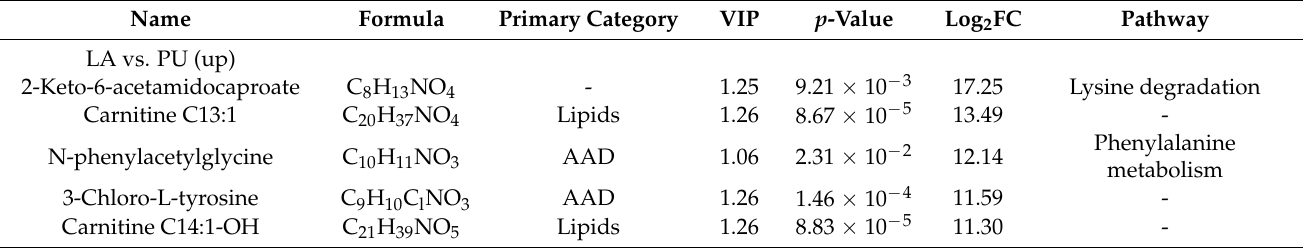
Table 2. The top five DAMs (up- or down) identified based on log 2 FC in transition of stages.